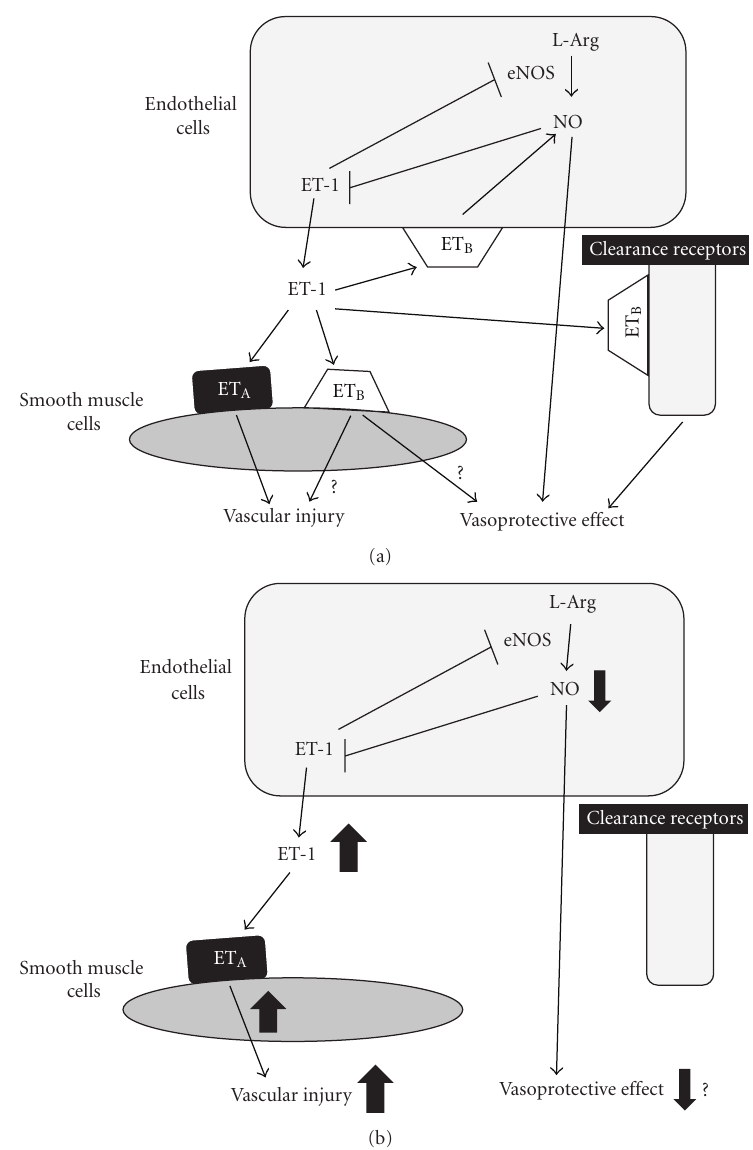
Figure 1: Roles of the ET-1/ET receptor system on vascular injury. (a) The vascular e ff ects of ET-1 are mediated by ET A and ET B receptors. ET A -mediated ET-1 action has been considered to cause vascular injury. ET B receptors are expressed not only on vascular smooth muscle cells, but also on endothelial cells. In addition, the ET B receptor is a clearance receptor of ET-1 from the circulation. However, the roles of the ET B receptor on vascular injury are still controversial. Recently, it was reported that nonendothelial ET B -receptor induced vasoprotective e ff ects, whereas another previous study demonstrated that ET B -receptor-mediated ET-1 action exhibited vasoprotective e ff ects via NO production [25, 26]. (b) Inhibition of the ET B receptor system leads to an aggravation of vascular injury. Increased circulating ET-1 levels because of clearance receptor inhibition and the augmentation of ET A -mediated actions are mainly responsible for aggravated vascular injury in the ET B receptor-inhibited condition [9]. ET, endothelin; NO, nitric oxide; eNOS; endothelial nitric oxide synthesis; L-Arg.